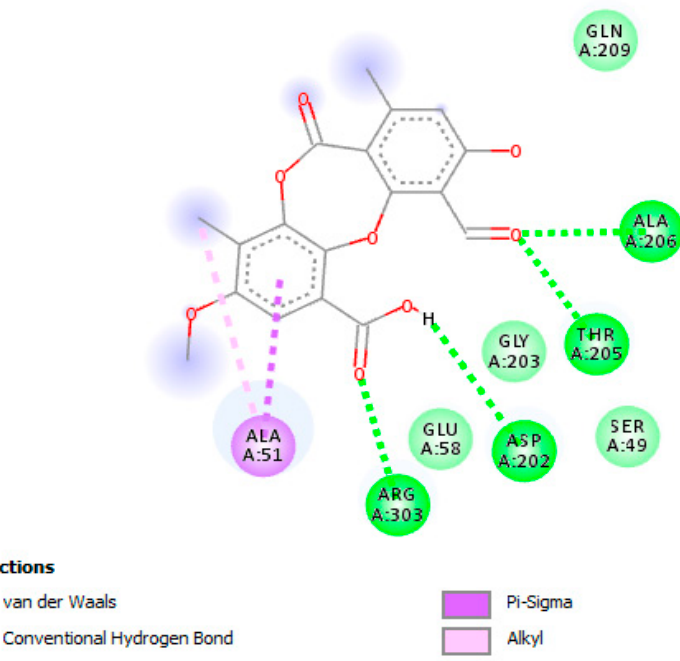
Figure 2. A two-dimensional interaction illustration of psoromic acid (PA) in the active site of UDP-galactopyranose mutase enzyme (UGM). Amino acid residues that are typically involved in UGM stabilization are portrayed. Several essential interactions including hydrogen bonding that connect amino acid residues are shown.